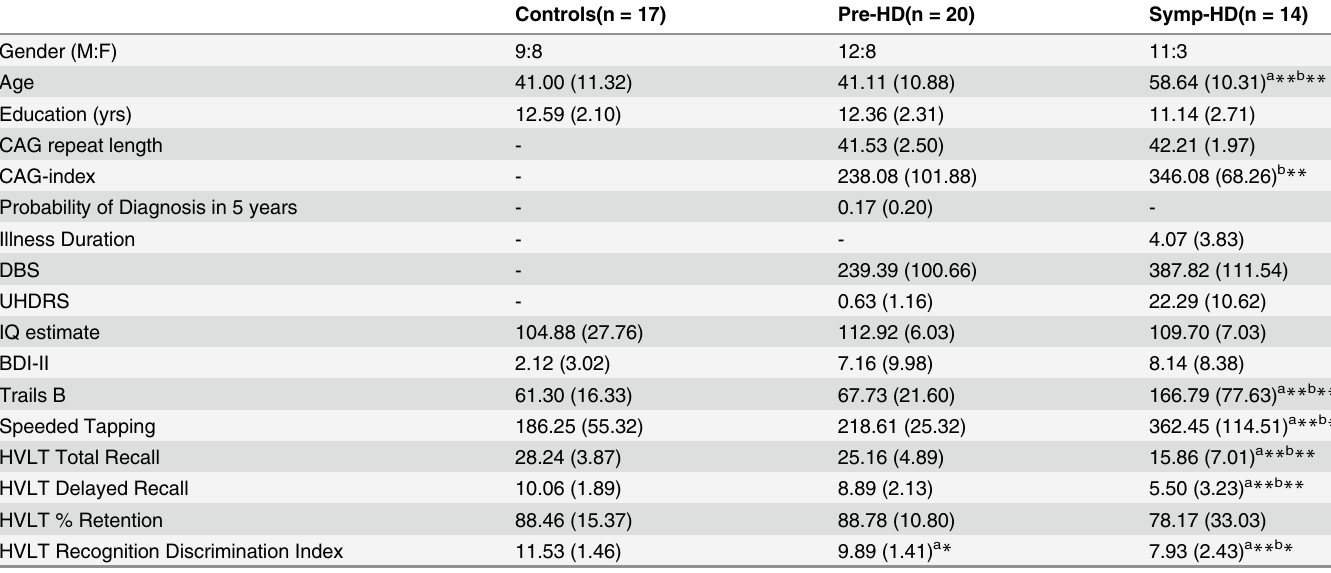
Table 1. Demographic data for participants included in analyses of RP and CNV task. Standard deviations (SD) provided in